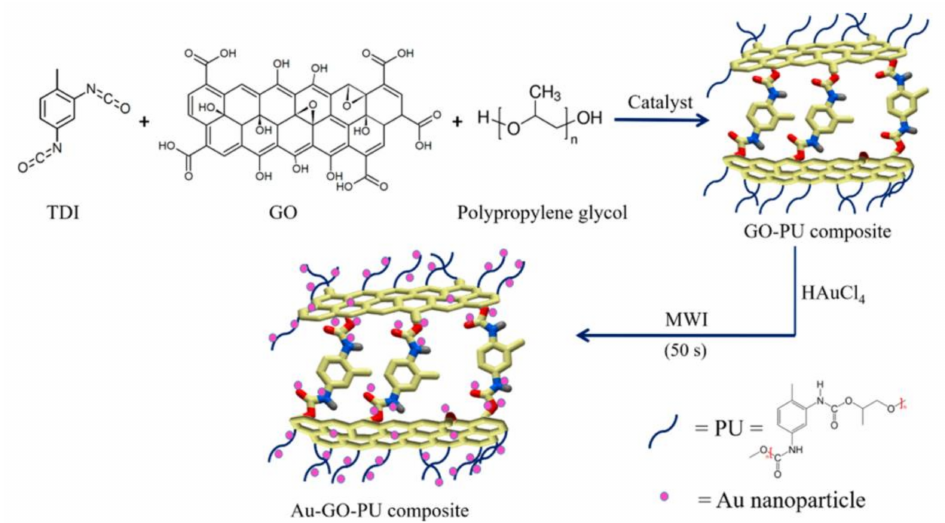
Figure 12. Design steps for the synthesis of PGPU nanocomposite foams [88] Reproduced with permission. Copyright 2017, American Chemical